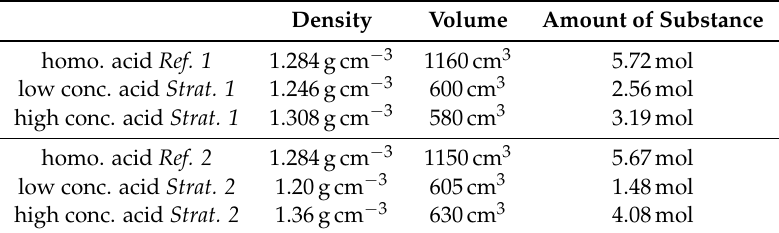
Table 1. Amount of acid with different densities to generate Strat. 1 and Strat. 2 .